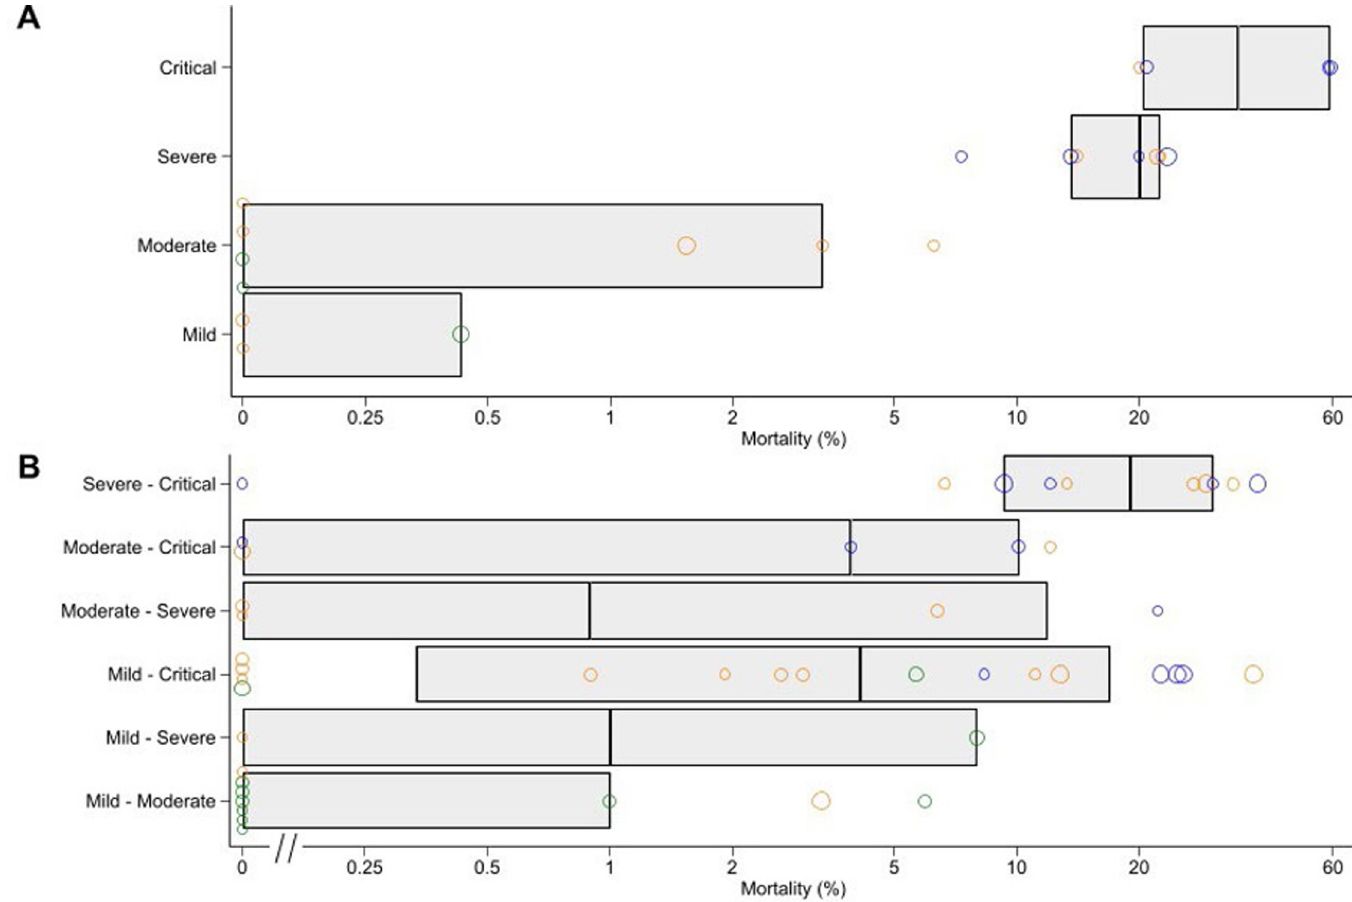
Fig 3. Trial mortality among trials with (A) only a single stratum of patient severity and (B) a range of possible patient severity as reported by https://www.covid19lnma. com/drug-treatments-study-level. Green circles are from trials with mean patient age < 50 years; orange for trials with mean patient age 50–60 years; blue for trials with mean patient age > 60 years. Boxes denote quartiles. Circle width corresponds to number of participants analysed ( < 75 participants; 75–150 participants; 150–300 participants; > = 300 participants from smallest to largest).